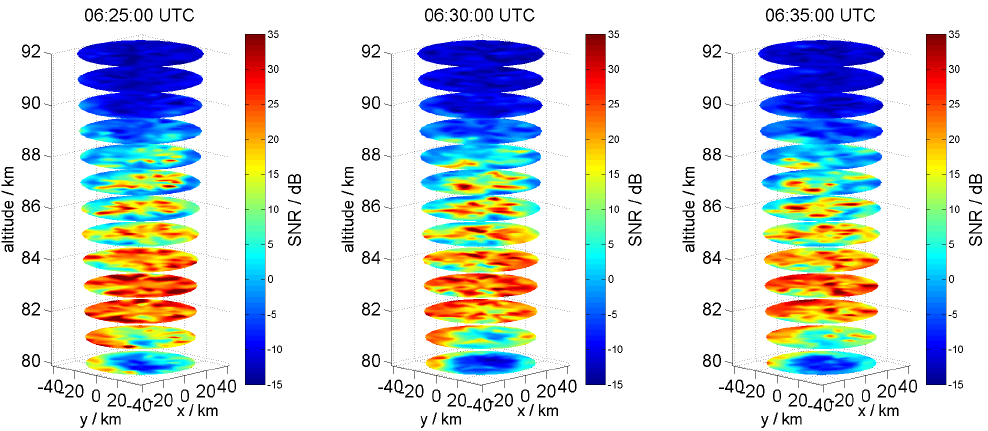
Fig. 4. RTI plot of the 3-D structure of the PMSE for three successive scans from 20 July 2011. The SNR for each beam direction was gridded using a cubic spline. The vertical distance between the horizontal slices is 1 km. The horizontal slices show a significant beam to beam as well as the temporal variability.